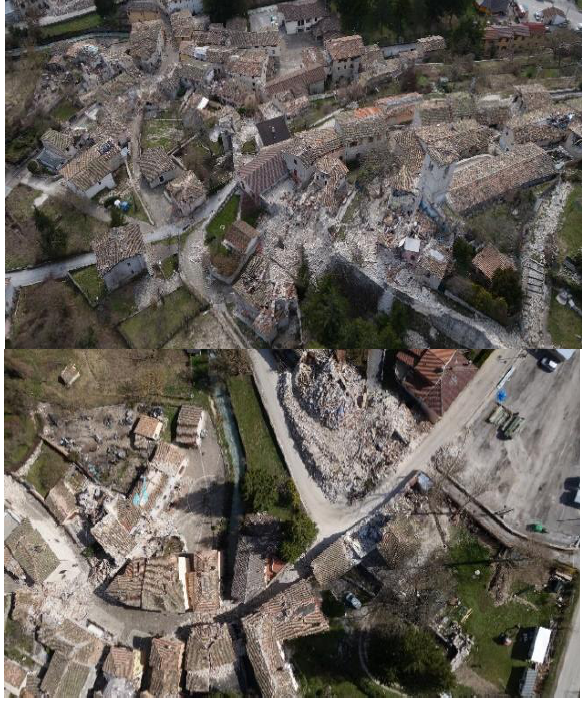
Figure 4. Images by UAV of Castelsantangelo sul Nera